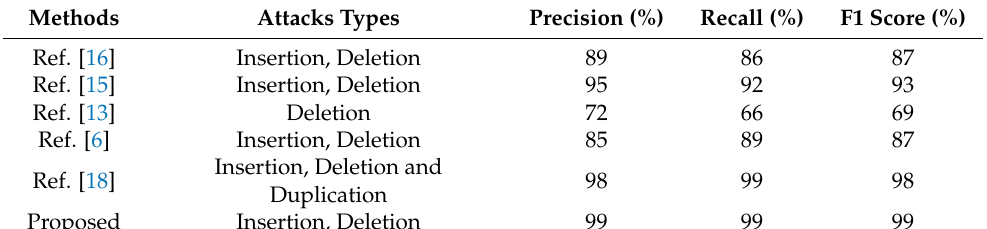
Table 7. Performance comparison between proposed approach and other related methods.